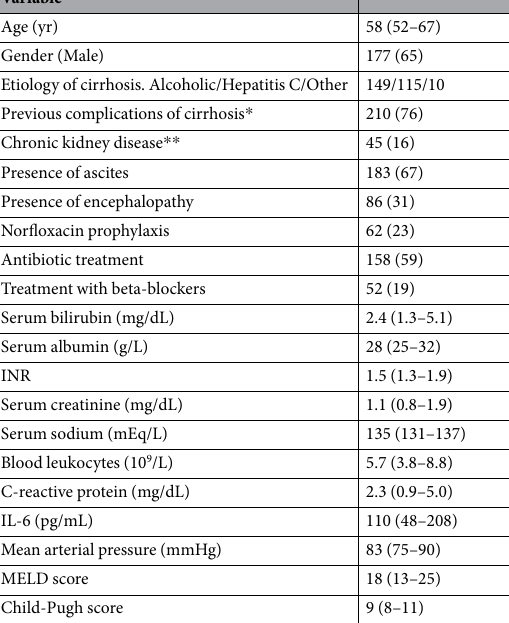
Table 1. Demographic, clinical and laboratory data of the 274 patients at inclusion. Categorical variables are expressed as numbers and percentages (in brackets), continuous variables are expressed as median (inter- quartile range). MELD, model of end stage liver disease; * Ascites/Hepatic Encephalopathy/GI bleeding/SBP: 188/88/69/23, respectively ** Parenchymal nephropathy in 26 patients and type-2 HRS in 24 patients, unknown in 2